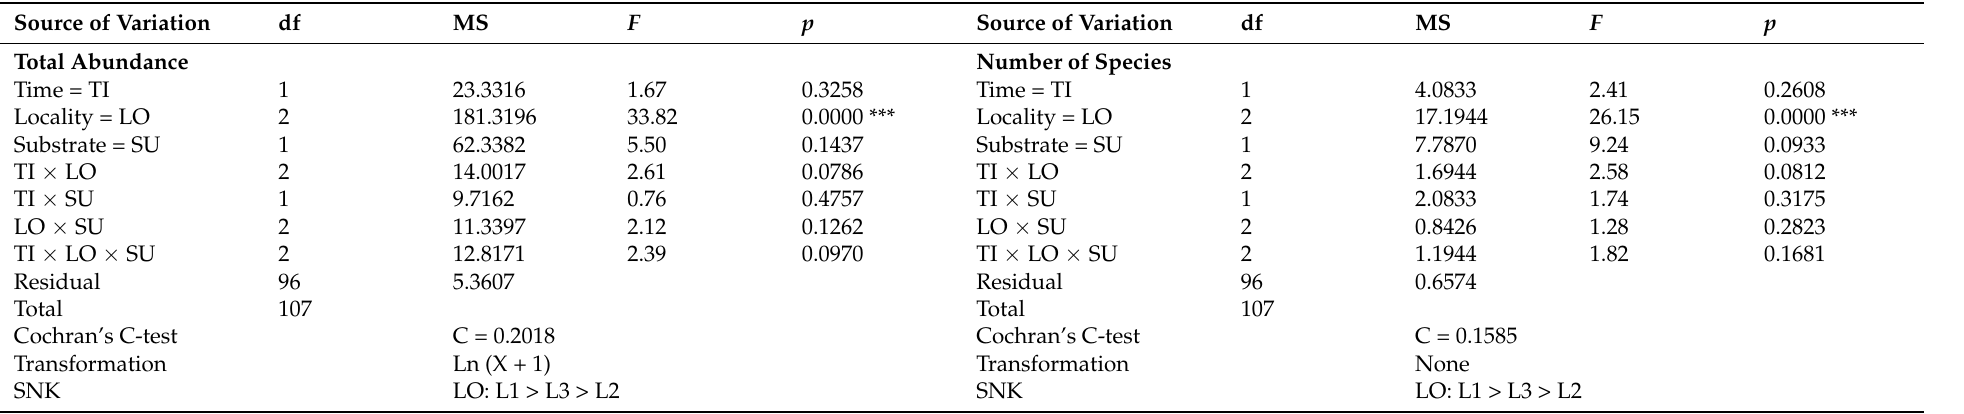
Table 1. Results of three-way analysis of variance (ANOVA) for the effect of the type of host substrate (SU, CO = collectors and LB = local basibionts), time (TI, T1 = one month, and T3 = three months) and locality (LO, L1 = Sancti Petri, L2 = Rota and L3 = Puerto Am é rica) on the total abundance and number of